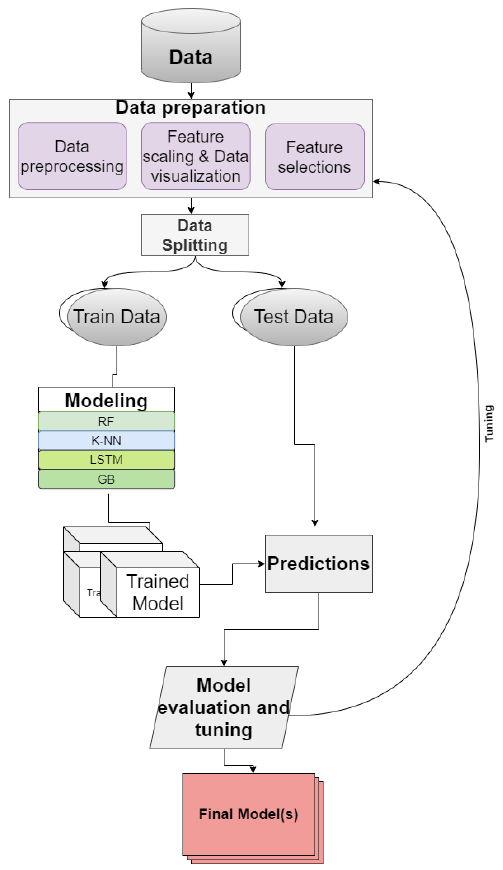
Figure 4. Modelling